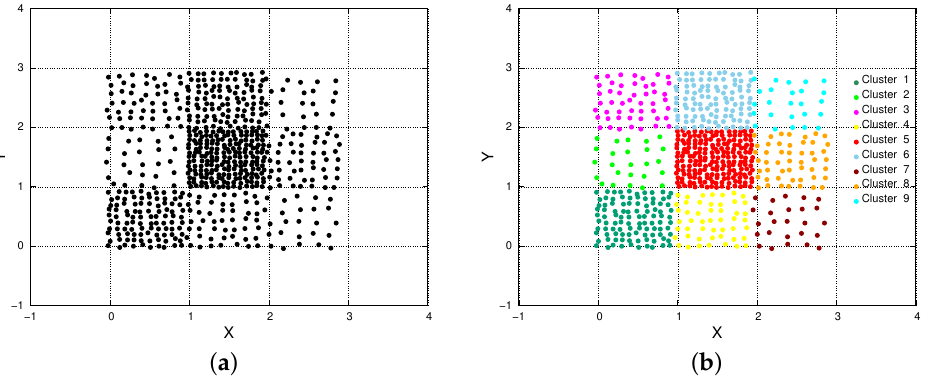
Figure 2. The Chess dataset: ( a ) data instances and ( b ) target clusters.